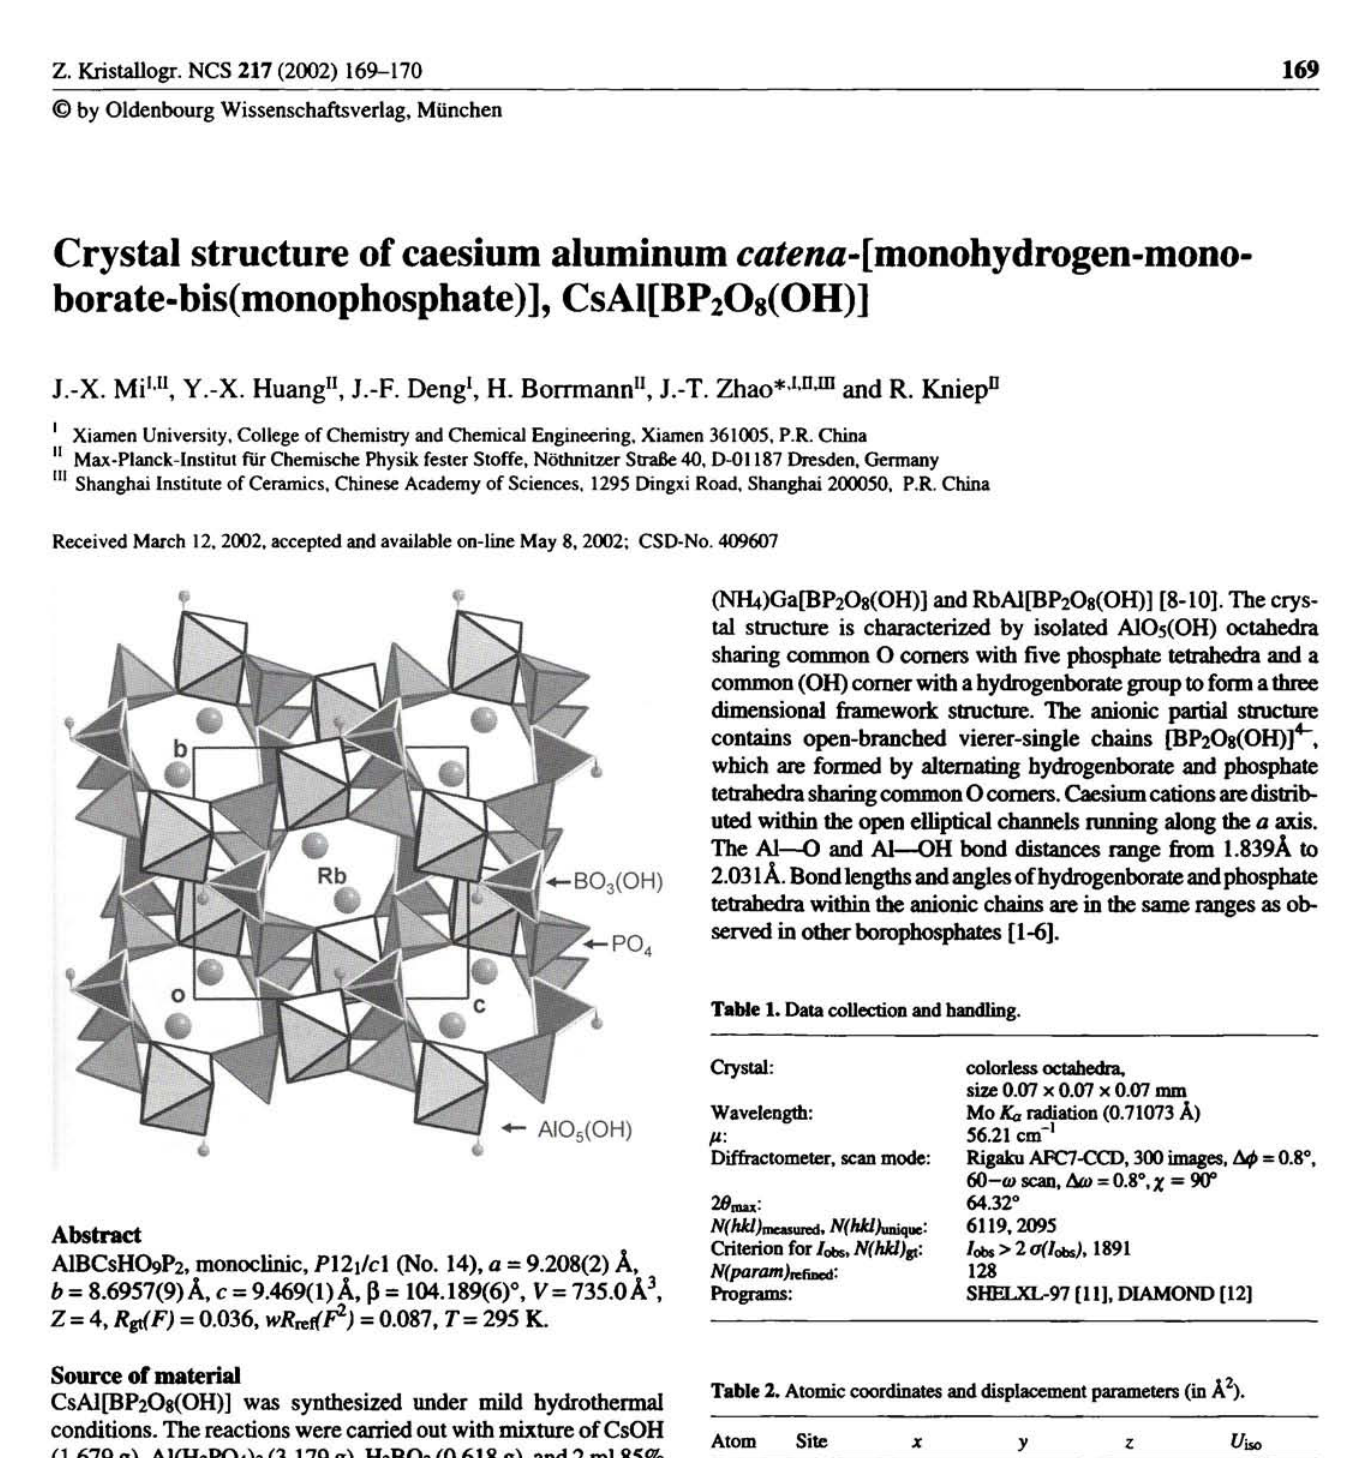
Table 2. Atomic coordinates and displacement parameters (in Â 2